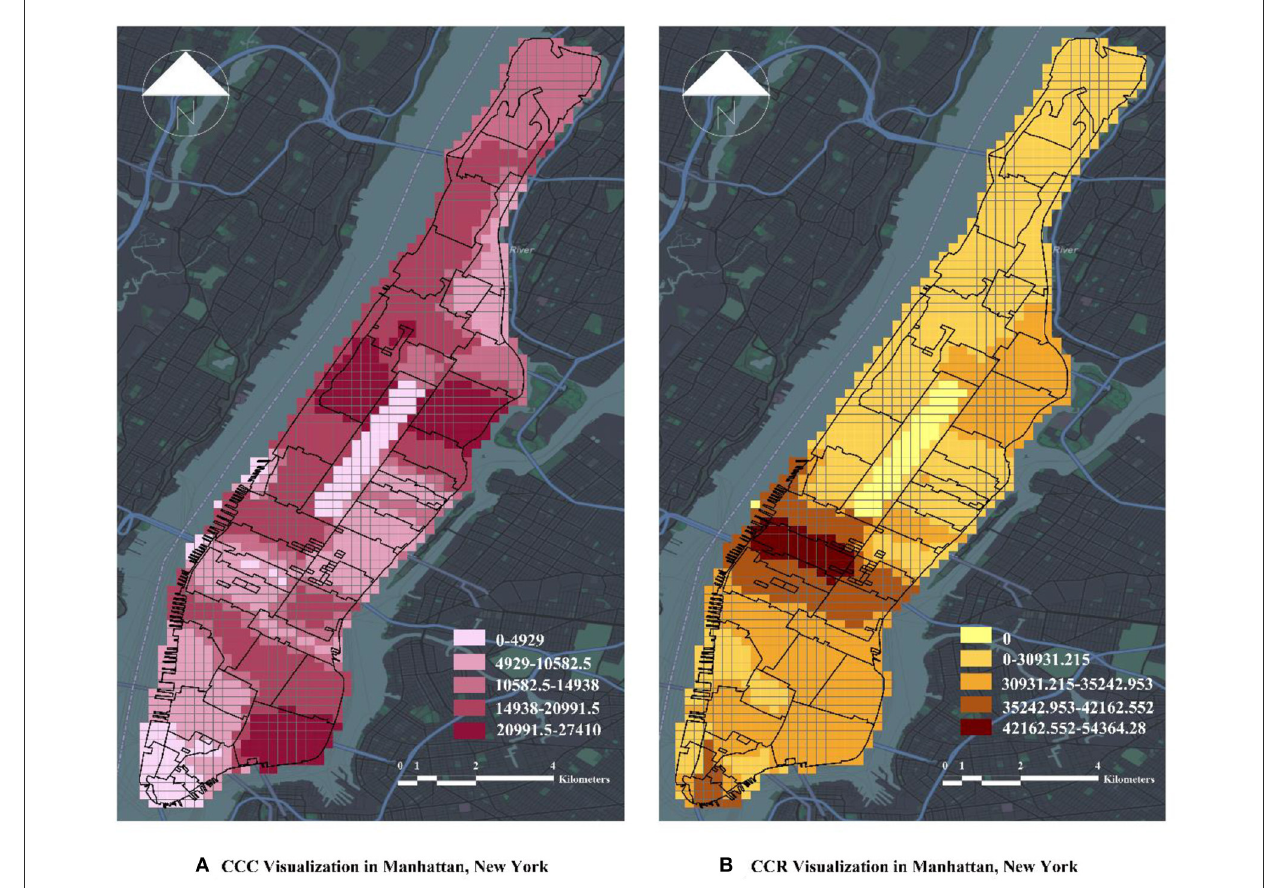
FIGURE3 Visualization of CCC and CCR in the study area. (A) CCC Visualization in Manhattan, New York. (B) CCR Visualization in Manhattan, New York.